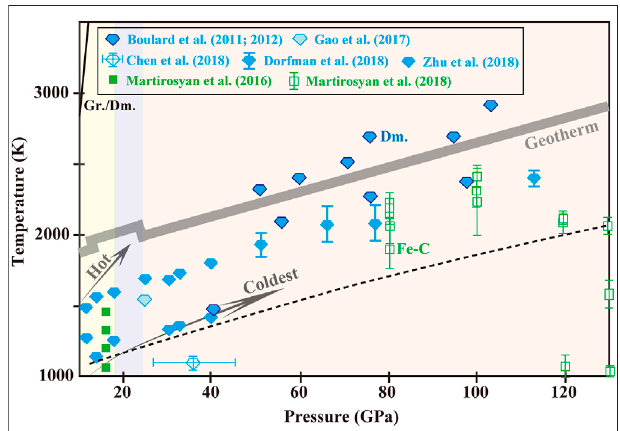
FIGURE 2 | Experimental pressure-temperature conditions and run products of carbonates-Fe 0 system. Blue diamond and green square represent formation of diamond (Dm.) and iron carbide (Fe-C), respectively, with uncertainties estimated for conditions marked. Diamond formation is always along with graphite generation. The dashed black curve is extrapolated from Zhu et al. (2018) for indicating the onset boundary of MgCO 3 -Fe 0